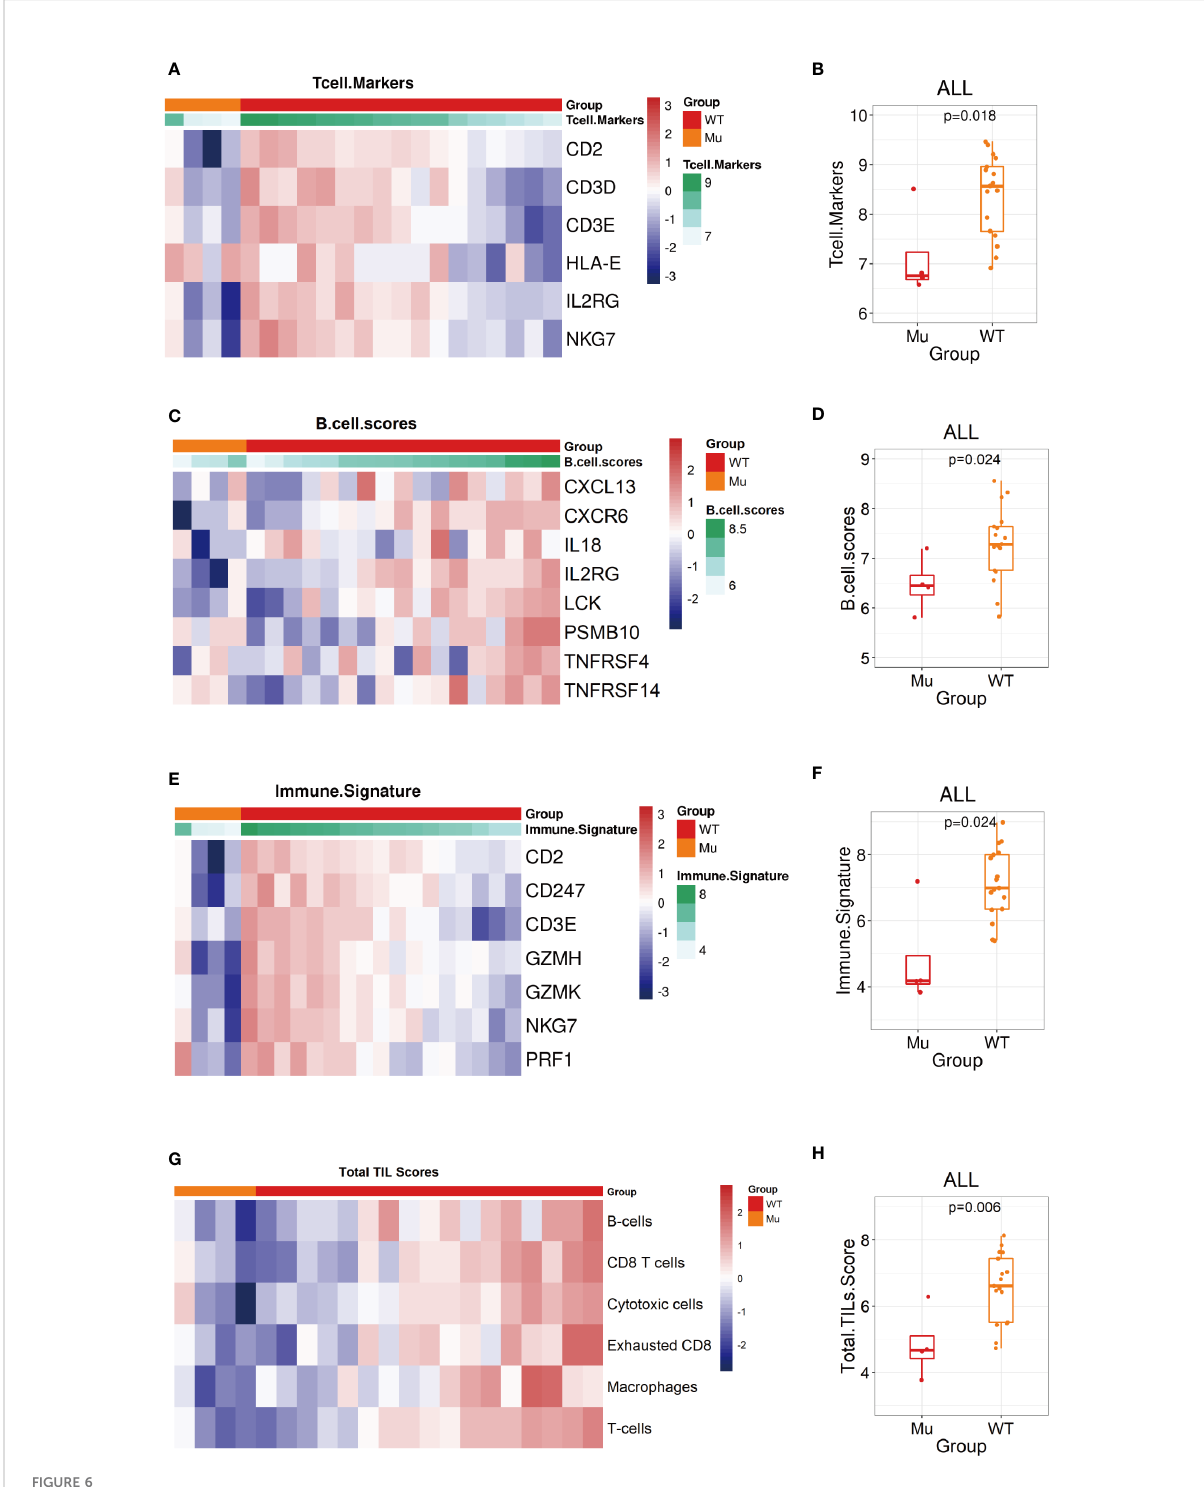
FIGURE 6 Biological signatures in the NOTCH1 mutation group. (A, B) The T cell markers score assessment shown as heatmap and the statistic analysis in two groups. (C, D) The B cell markers score assessment shown as heatmap and the statistic analysis in two groups. (D, E) The immune signature score assessment shown as heatmap and the statistic analysis in two groups. (G, H) The total TILs score assessment shown as heatmap and the statistic analysis in two